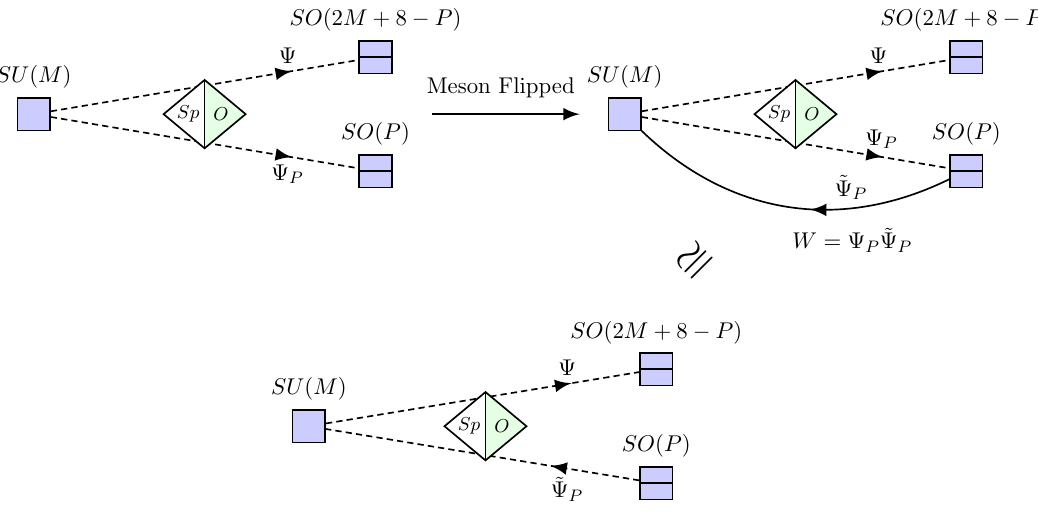
Figure 13. Comparison of different abstract quiver notations for the q diagram the enhanced Spin(2 M + 8) symmetry is manifest.